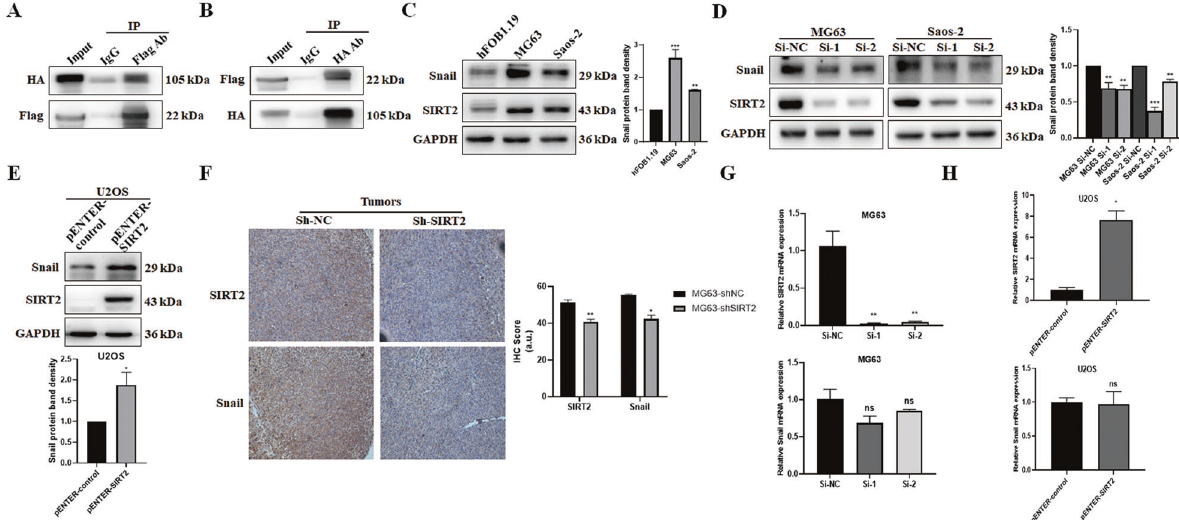
Fig. 7 SIRT2 positively regulates the expression of Snail. A , B The pENTER-SIRT2-c-Flag-His and pcDNA3.1-Snail-c-HA plasmids were transfected into MG63 cells, and the binding of exogenous SIRT2 and Snail was detected by Co-IP. C Western blot was used to detect Snail expression in MG63 and Saos-2 cells. Data from a representative experiment of at least three independent samples are shown. D The expression of Snail was detected after SIRT2 knockdown in MG63 and Saos-2 cells. Data from a representative experiment of at least three independent samples are shown. E The expression of Snail was detected after SIRT2 overexpression in U2OS cells. F Immunohistochemical staining of SIRT2 and Snail was performed on the tumor tissues of the MG63-shSIRT2 group and control group. Immunohistochemical scores are summarized in a histogram format. G , H qRT-PCR was employed to detect Snail mRNA levels with SIRT2 knockdown or overexpression. (* P < 0.05, ** P < 0.01, *** P <